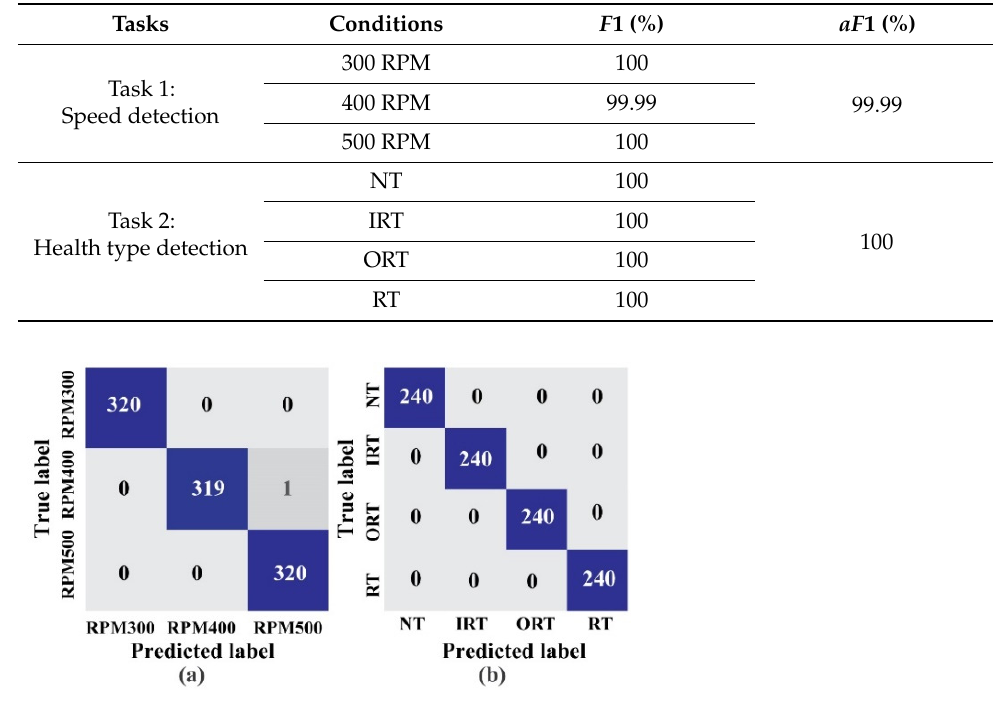
Figure 10. Confusion matrices: ( a ) Task 1: speed detection, and ( b ) Task 2: health type detection.